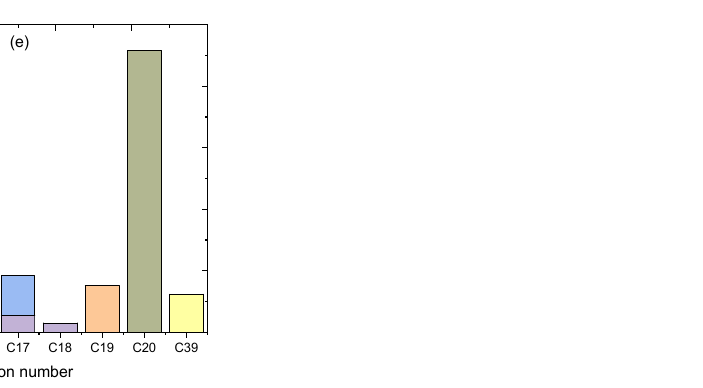
Figure 14. ( a ). Carbon number distribution for the algal HO. ( b ). Carbon number distribution for the Figure 14. ( a ) . Carbon number distribution for the algal HO. ( b ) . Carbon number distribution for products of the catalytic deoxygenation of the algal HO for HZSM-5. ( c ). Carbon number distribution the products of the catalytic deoxygenation of the algal HO for HZSM-5. ( c ) . Carbon number dis- tribution for the products of the catalytic deoxygenation of the algal HO for for the products of the catalytic deoxygenation of the algal HO for (2.5%La-7.5%Ce)/HZSM-5. ( d ). (2.5%La-7.5%Ce)/HZSM-5. ( d ) . Carbon number distribution for the products of the catalytic de- Carbon number distribution for the products of the catalytic deoxygenation of the algal HO for (5%La- oxygenation of the algal HO for (5%La-5%Ce)/HZSM-5. ( e ) . Carbon number distribution for the 5%Ce)/HZSM-5. ( e ). Carbon number distribution for the products of the catalytic deoxygenation of products of the catalytic deoxygenation of the algal HO for (7.5%La-2.5%Ce)/HZSM-5. the algal HO for